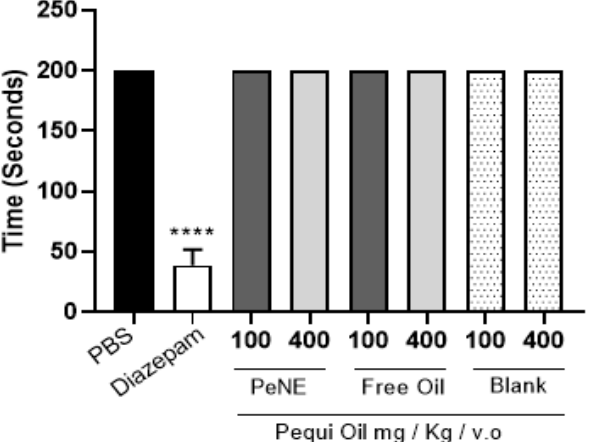
Figure 7. Rota-rod test in rats pre-treatment with free oil (100 and 400 mg/kg/p.o.), nanoencapsulated pequi oil (PeNE 100 and 400 mg/kg/p.o.), blank, or diazepam. The control group was treated with PBS. PeNE, free pequi oil, and the blank were administered daily for 15 days prior to carrageenan injection. Latency to falling (in seconds) on the rotating rod. The data are expressed as mean ± SEM; ( n = 4–7). **** p < 0.0001 compared to control group; one-way ANOVA.